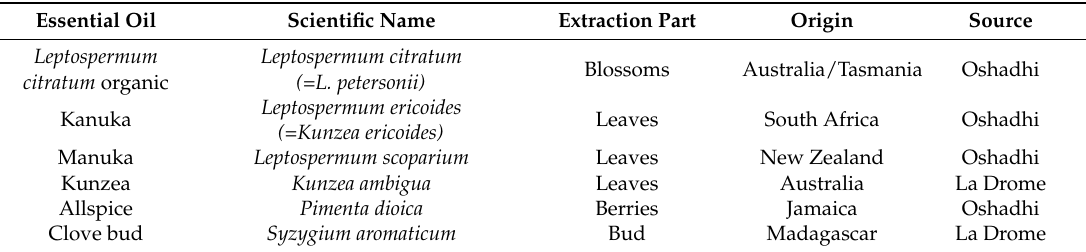
Table 5. List of tested essential